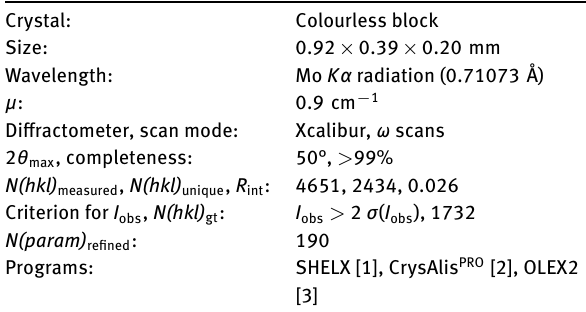
Table 2: Fractional atomic coordinates and isotropic or